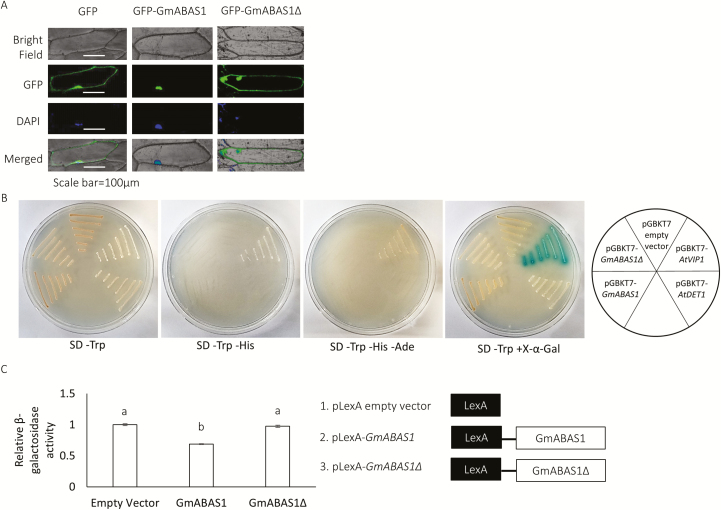
GmABAS1 exhibited transcriptional repressor activities. (A) Detection of the subcellular localization of GmABAS1 and GmABAS1∆ using GFP fusion proteins. GFP was fused to the N-terminus of GmABAS1 or GmABAS1∆, and the fusion construct was cloned into the plasmid V7, downstream of a CaMV 35S promoter. The plasmid DNA was coated onto gold particles which were then bombarded into onion epidermal cells. DAPI was used to stain the nucleus. Green fluorescence signals were analysed as described in the Materials and methods. For each construct, all cells giving the GFP signal showed the same pattern. The experiment was performed twice with similar results. (B) Transactivation assay using the yeast strain Y2HGold. GmABAS1, GmABAS1∆, AtVIP1 (a transcriptional activator, positive control), or AtDET1 (a transcriptional repressor, negative control) was cloned into the plasmid pGBKT7 to produce Gal4BD fusion proteins. The transgenic yeast cells were selected by SD-Trp medium. Metabolic markers HIS3, ADE2, and MEL1 were used to report transactivation activities. The transgenic yeast cells expressing Gal4BD-GmABAS1 or Gal4BD-GmABAS1∆ could not grow on medium without His and/or Ade. The transgenic yeast cells also could not hydrolyse X-α-Gal. The experiment was performed twice with similar results. (C) Transcriptional repression assay using the yeast strain W303a. GmABAS1 or GmABAS1∆ was cloned into the plasmid pLexA which was then transformed into W303a. The transgenic yeast was then co-transformed with either the JK1621 plasmid carrying the LacZ gene, driven by the minimal promoter CYC1 downstream of the LexA-binding sites, or with the pLGΔ312S plasmid without the LexA-binding sites. The β-galactosidase activities of the yeast co-transformed with JK1621 and pLexA plasmids were normalized by the activities of the yeast co-transformed with pLGΔ312S and the corresponding pLexA plasmids. Error bars represent SEs of three technical repeats. Each lower case letter above the bars indicates a statistically distinct group with P<0.05 based on one-way ANOVA followed by Tukey HSD test. The experiment was performed twice with similar results.